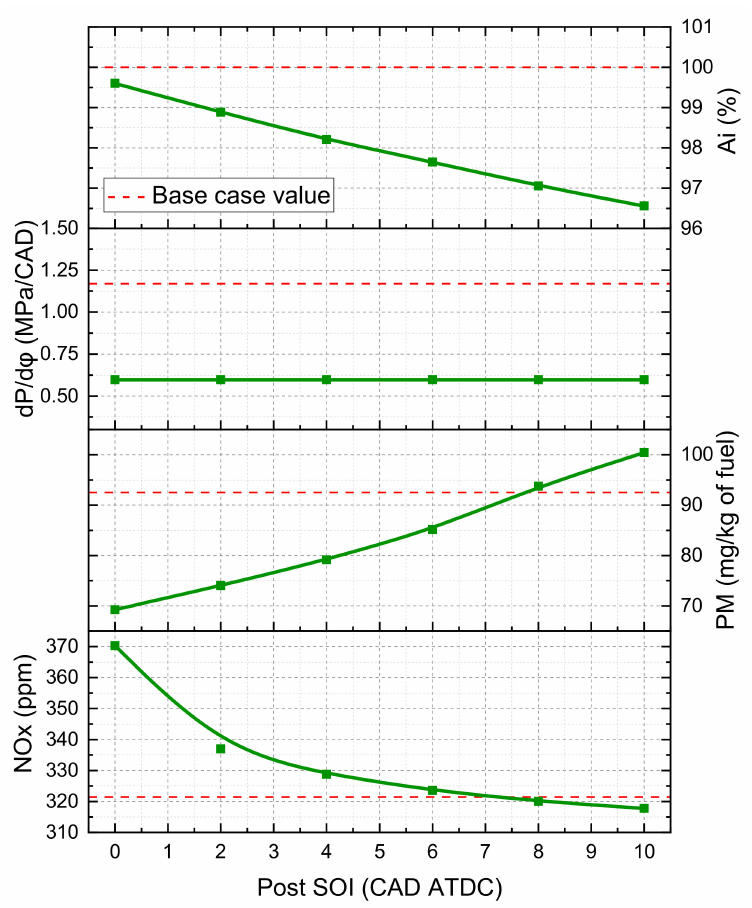
Figure 16. The post SOI variable influence on combustion process and